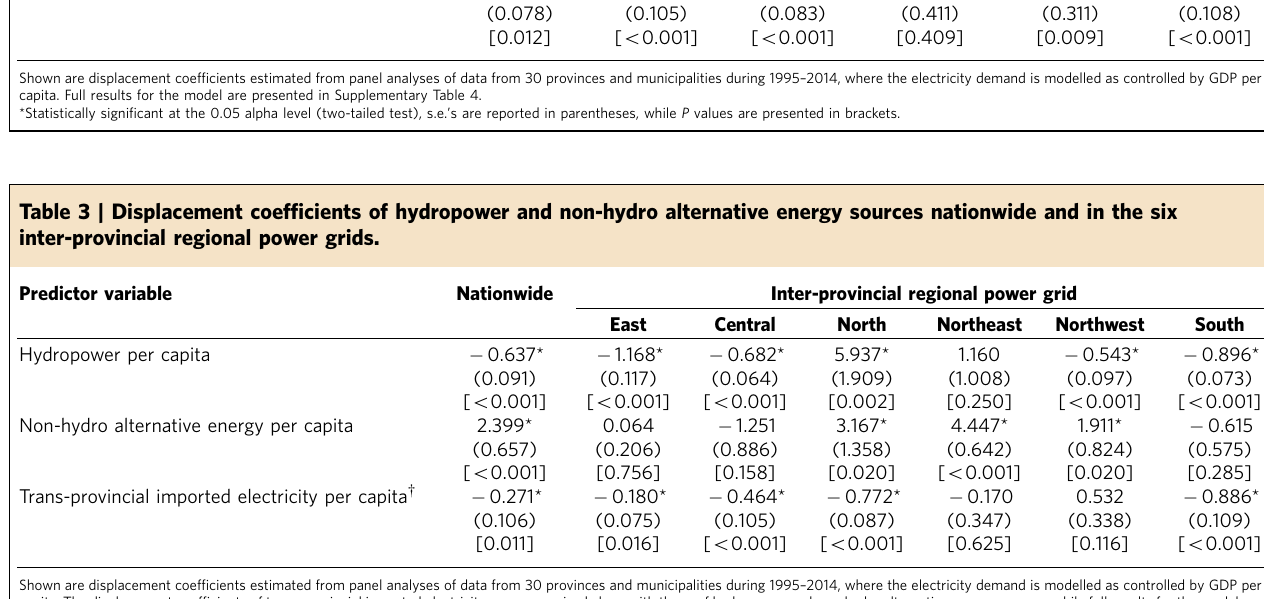
Shown are displacement coefficients estimated from panel analyses of data from 30 provinces and municipalities during 1995–2014, where the electricity demand is modelled as controlled by GDP per capita.Thedisplacementcoefficientsoftrans-provincialimportedelectricityaresummarizedalongwiththoseofhydropowerandnon-hydroalternativeenergysources,whilefullresultsforthemodelare presented in Supplementary Table 7. *Statistically significant at the 0.05 alpha level (two-tailed test), s.e.’s are reported in parentheses, while P values are presented in brackets. w As expected, the displacement coefficients for trans-provincial imported electricity nationwide and in the six regional grids are comparable to those obtained by the previous models (Tables 1 and